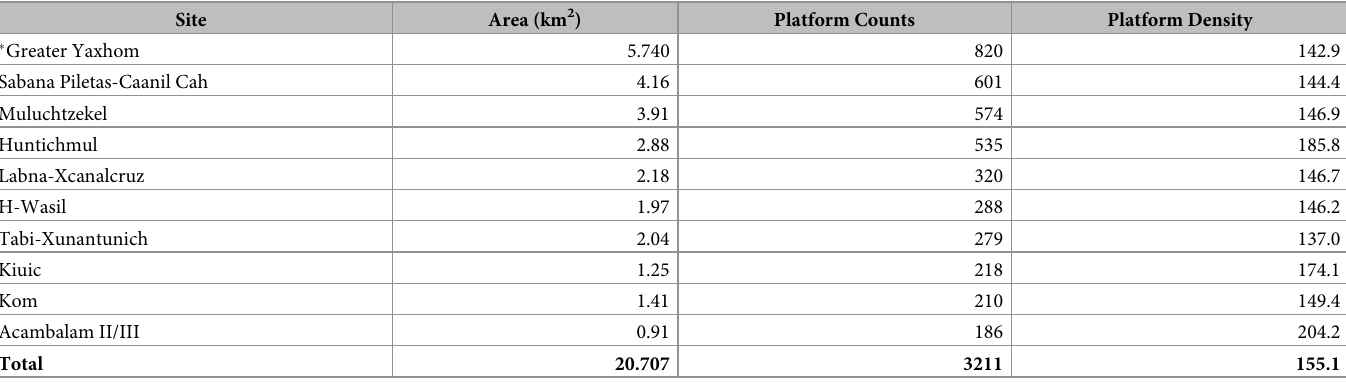
Table 5. Site core � statistics of the ten largest communities.